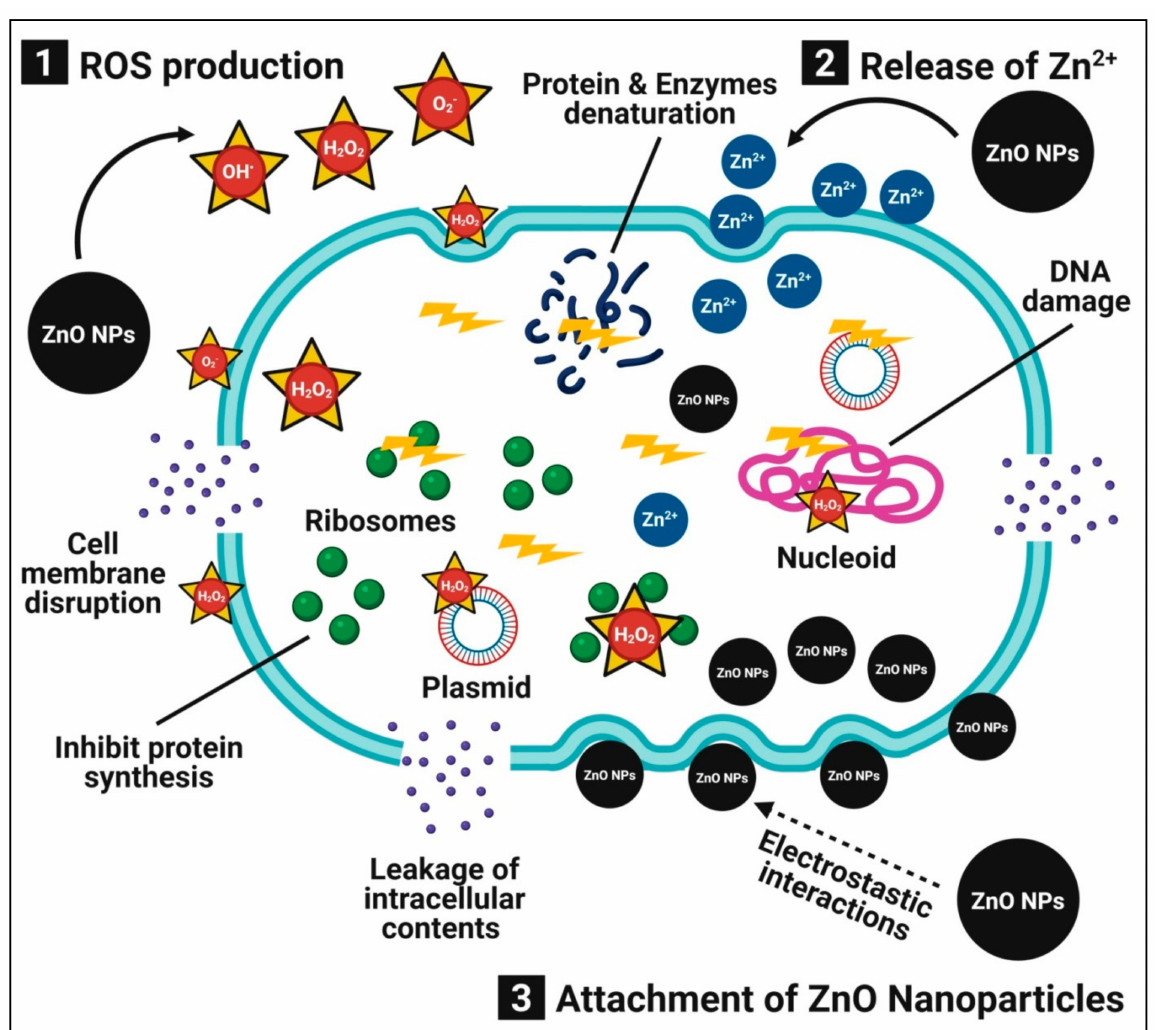
Figure 1. Possible antibacterial mechanisms of plant-mediated zinc oxide